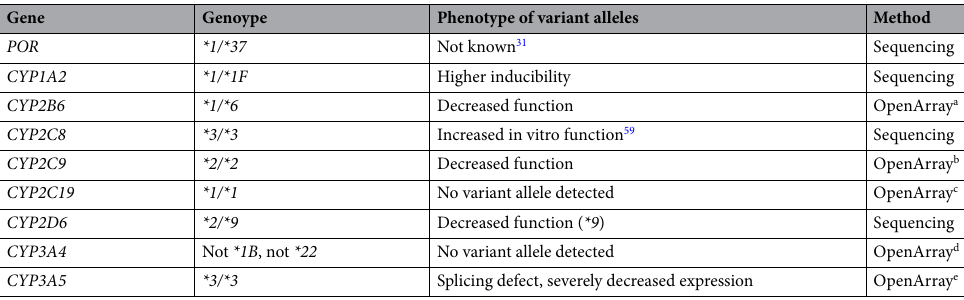
Table 1. Genotypes of POR, CYP1A2, CYP2B6, CYP2C8, CYP2C9, CYP2C19, CYP2D6 and CYP3A4 in HepaRG cells. Predesigned Taqman assays: a AHFBATH, C__60732328_20, AHABIR9. b